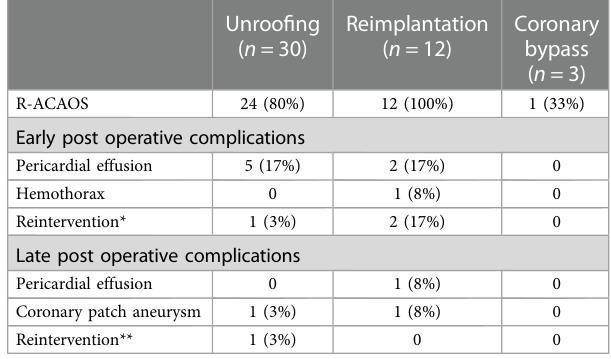
TABLE 2 Early and late postoperative complications according to surgical technique.